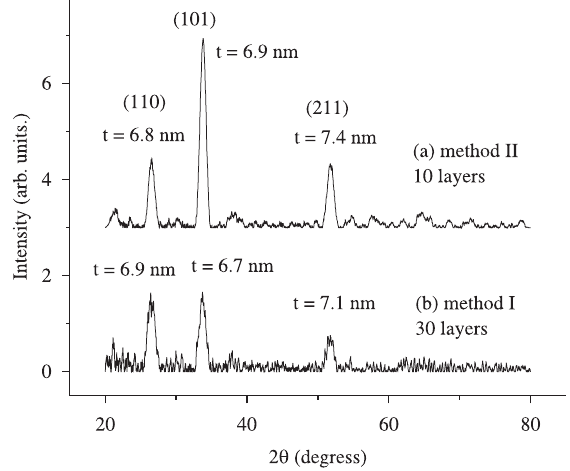
Figure 2. X-ray diffractogram for undoped SnO method II – 10 layers and b) obtained by method I – 30 layers. The three mean directions are indicated along with the evaluated crystallite